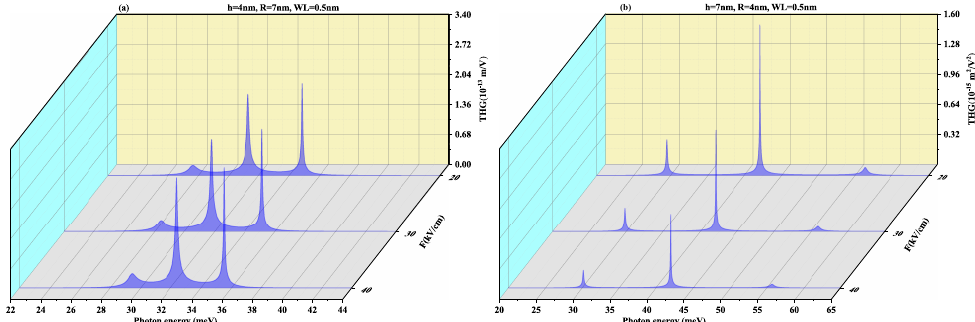
Figure 9. Third harmonic generation as a function of the photon energy for ( a ) oblate height R = 4 nm with radius R = 7 nm at WL thickness 0.5 nm ( b ) prolate QD with R = 4 nm, h = 7 nm with WL thickness = 0.5 nm for different values of lateral electric field F = 20,30 and 40 kV/cm. To observe the effect of the wetting layer in the QD geometry, we have plotted the SHG and THG at a WL thickness of 1 nm for both oblate (h = 4 nm and R = 7 nm) and prolate (h = 7 nm and R = 4 nm) QD in Figures 10 and 11, respectively. On increasing the WL thickness to 1 nm, the redshift arises in resonance peaks for SHG and THG. With an increase in an electric field, the same results are achieved for SHG with a slight increase in magnitude as for Figure 8 and THG results are similar to Figure 9 with a decrease in amplitude, with an increase in WL